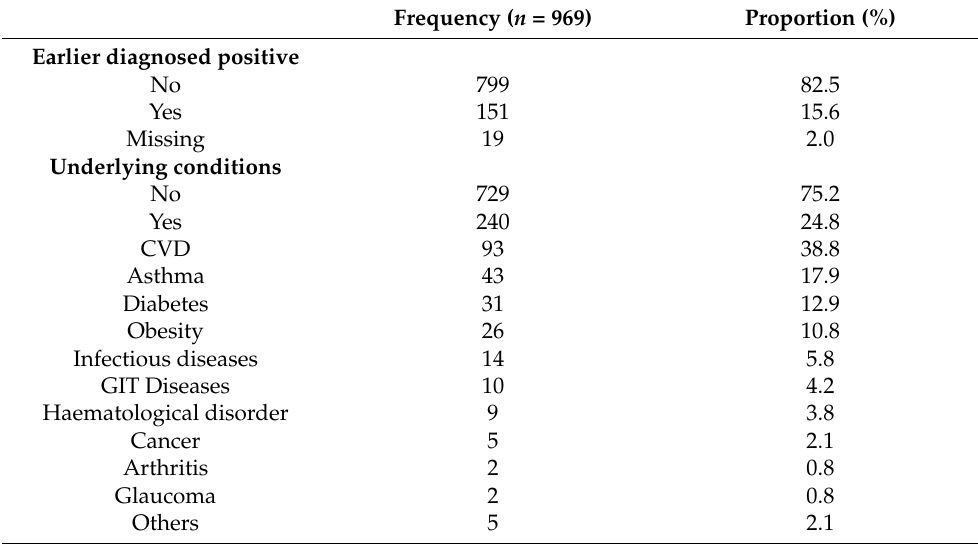
Table 3. African respondents earlier diagnosed positive for SARS-CoV-2 and underlying conditions before COVID-19 vaccination.